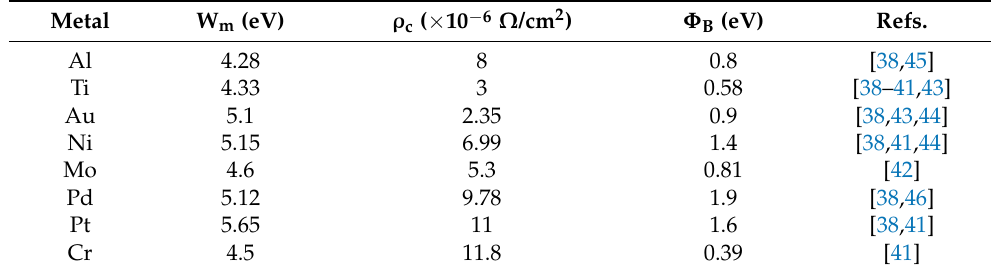
Table 1. W m , ρ c , Φ B characteristics of different metals to (Al)GaN.